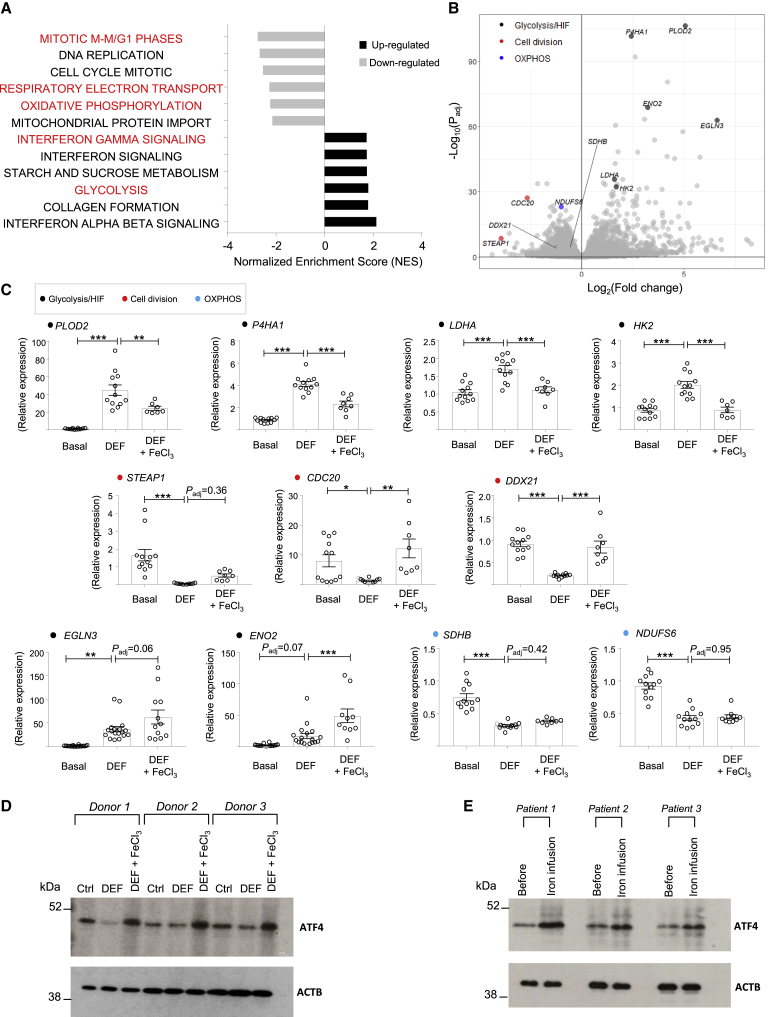
Acute Iron Deprivation Causes an Atypical Warburg Transcriptome and Mediates an ATF4-Driven Transcriptional Response in Human Macrophages(A) Gene set enrichment analysis (GSEA) in upregulated and downregulated transcripts between control (basal) and DEF-treated human macrophages (500 μM, 24 h), measured by RNA-seq (n = 3 donors; Fc > 1.5; Padj < 0.01).(B) Volcano plot from RNA-seq highlighting genes belonging to glycolysis-HIF, cell division, and OXPHOS pathways.(C) qRT-PCR for main glycolysis-HIF, cell division, and OXPHOS genes (color-coded) in iron-deprived (DEF, 500 μM, 24 h) and rescued human macrophages with short exposure (8 h) to 200 μM ferric chloride (DEF + FeCl3); n = 4–9 donors/group.(D) ATF4 western blotting in iron-deprived (DEF) and rescued (DEF + FeCl3) human macrophages from three donors.(E) ATF4 western blotting before and after 2 h of intravenous iron transfusion (Ferinject 1–1.5 g) in 3 CKD patients’ PBMCs (see Method Details and Table S1 for patient information). ∗p < 0.05, ∗∗p < 0.01, and ∗∗∗p < 0.001 by ANOVA followed by Tukey’s multiple comparisons test. Padj, adjusted p value; Fc, fold change. Error bars represent SEM.See also Figures S1 and S2.